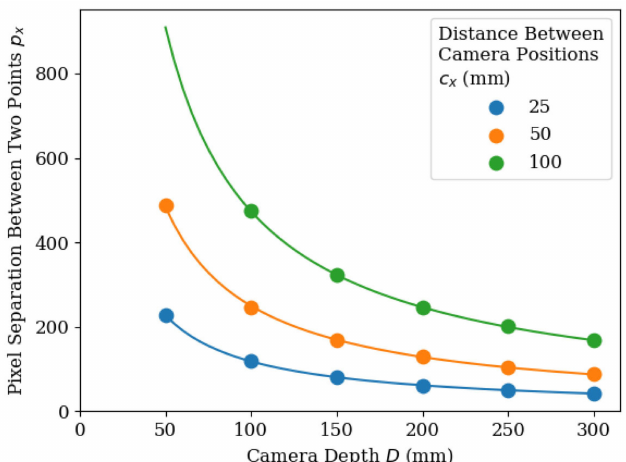
Figure 11. Graph showing the relationship between camera depth and pixel separation between two points. Two points were set apart at distances of 25 mm, 50 mm and 100 mm. The camera was set to face the points at known depths and the pictures were taken. The pixel separation between the points in each image was